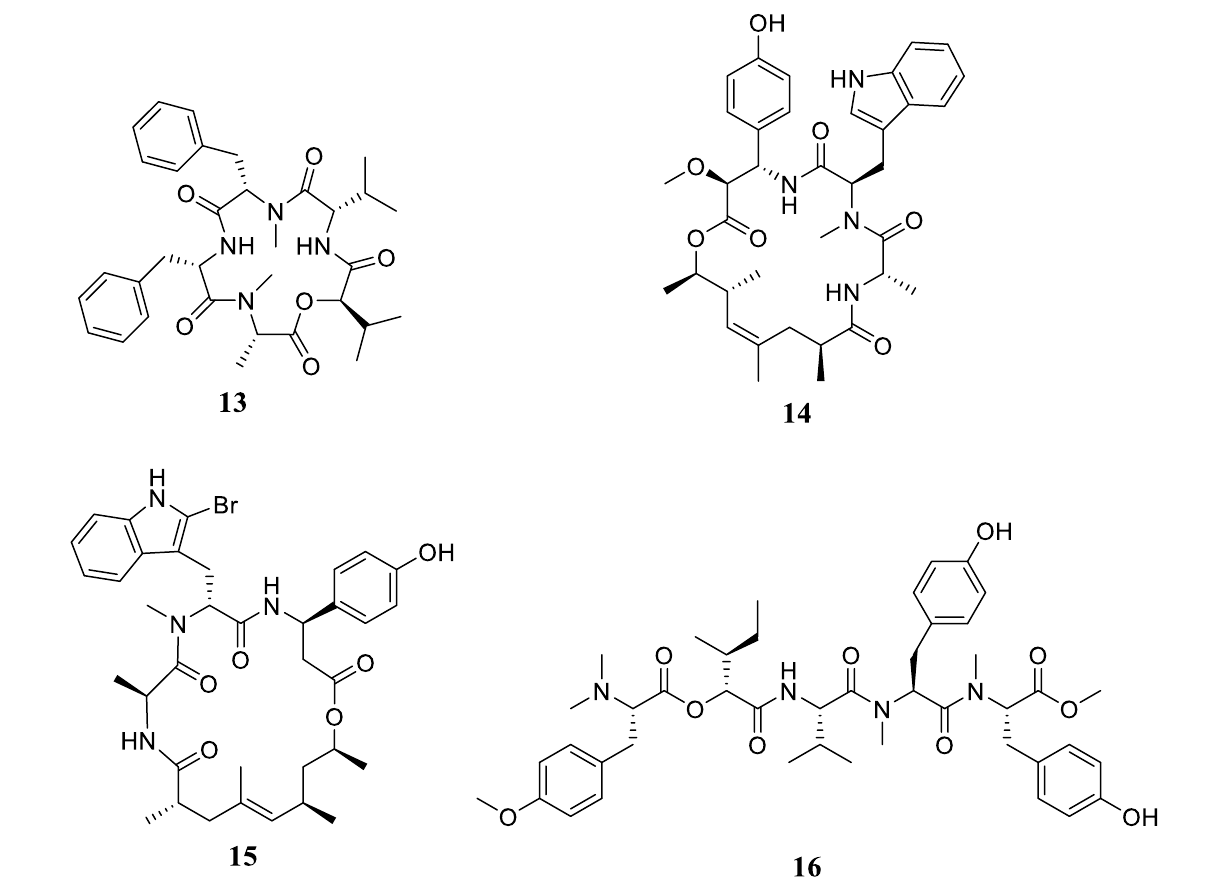
Figure 5. Chemical structures of acremonamide ( 13 ), chondramide A ( 14 ), jasplakinolide ( 15 ), and apratyramide ( 16 ) .